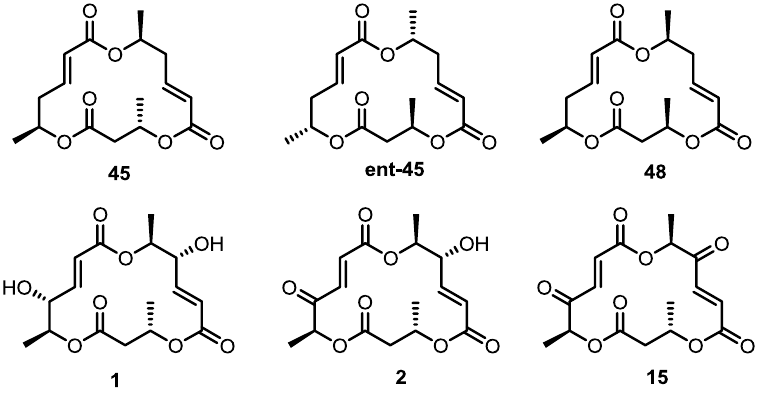
Figure 3. MS and Modified MS Core